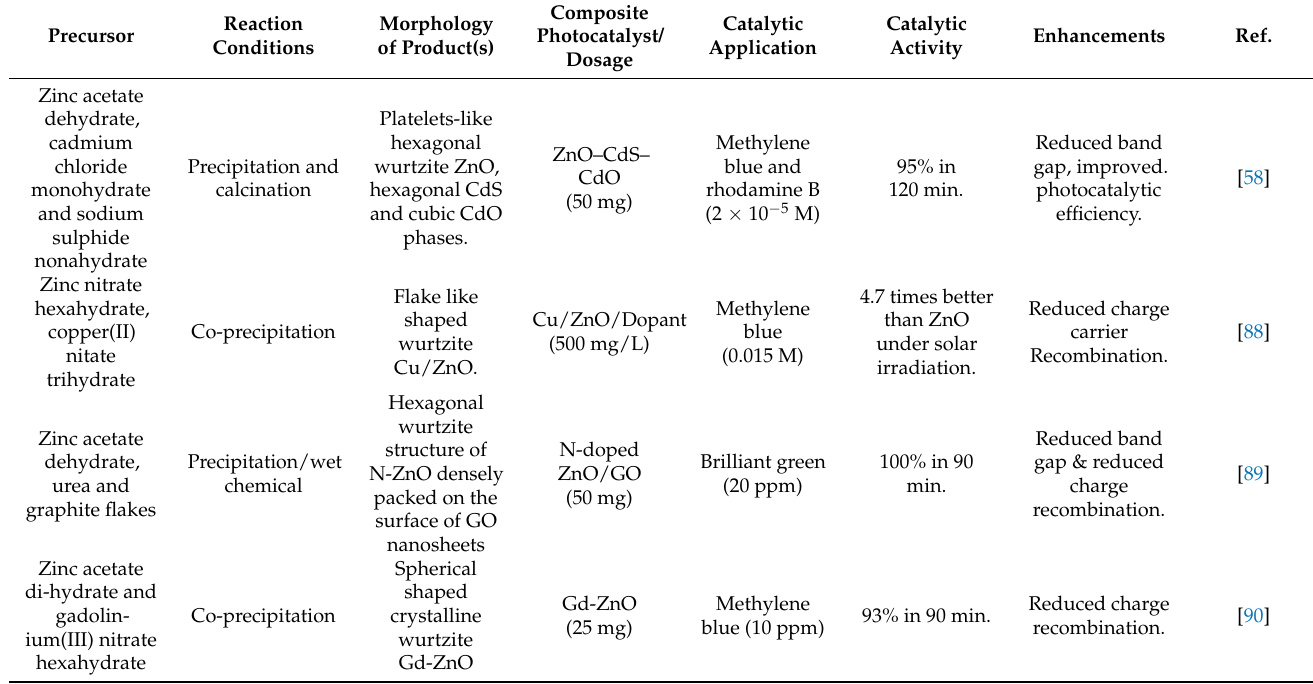
Table 3. Catalysts prepared by